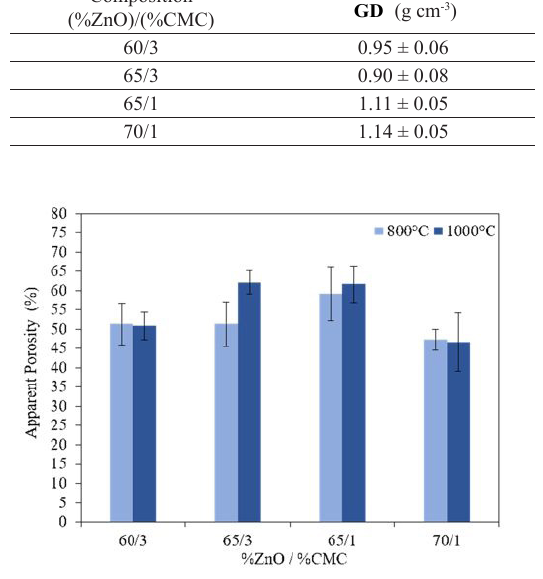
Figure 4. Apparent porosity of heat-treated ZnO ceramics at 800 ºC/2 h and 1000 ºC/2 h, in accordance with ABNT NBR 9778 29